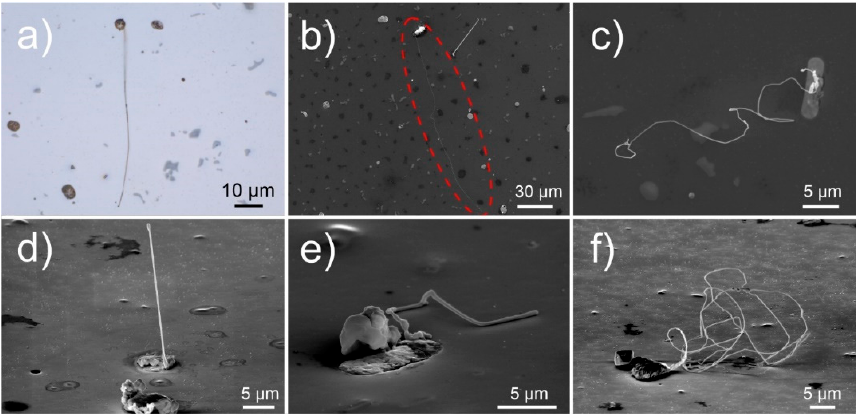
Figure 1. Micrographs of Pb whiskers obtained with ( a ) light microscopy, and ( b – f ) scanning electron microscopy (secondary electron imaging). Images ( d , e ) are obtained by tilting the sample by 70°. The whiskers mainly grow from the edges of the pools, which is a result of the inter- nal structure of the pools that consist of two defining regions. The inner piece consists of Bi incorporating Mg with atomic fraction from 5% to 45%. The combination of both ele- ments suggests a double phase system constructed of Bi 2 Mg 3 and Bi, which was also ob- served clearly in certain pools (see insert in Figure 2a). With energy-dispersive X-ray spec- troscopy (EDS), presence of oxygen was detected with atomic fraction of 2/3x to 1x the atomic fraction of Bi, suggesting that most of the upper part of Bi is in oxide form (see supporting Figure S1). The outer part of the pool from which the whiskers grow (between Bi region and the aluminum matrix) consists of pure Pb (marked in Figure 2a) covered by an oxide (PbO) layer. The whiskers are confirmed to be mainly composed of Pb at which occasionally Bi is present in them in the form of solid solution (5–18 at.%), when the whisk- ers grow from or near the Pb–Bi interface. The whisker growth is induced by the compres- sive stresses built by a combination of the quenching process of aluminum alloy from the high temperature as well as by the different solidification temperatures and different ther- mal expansion coefficients of the matrix and individual pool regions [38,39]. The whisker growth from the pools results in the fascinating morphologies, which to the authors’ knowledge have previously not been reported for whiskers and other spontaneous growth of crystals from metal surfaces. The occurrence of the unique whisker and hillock morphologies have been identified to occur considerably often, since from 1300 observed whiskers and hillocks, around 700 displayed the unique morphologies that are discussed through representative examples in the following sections.